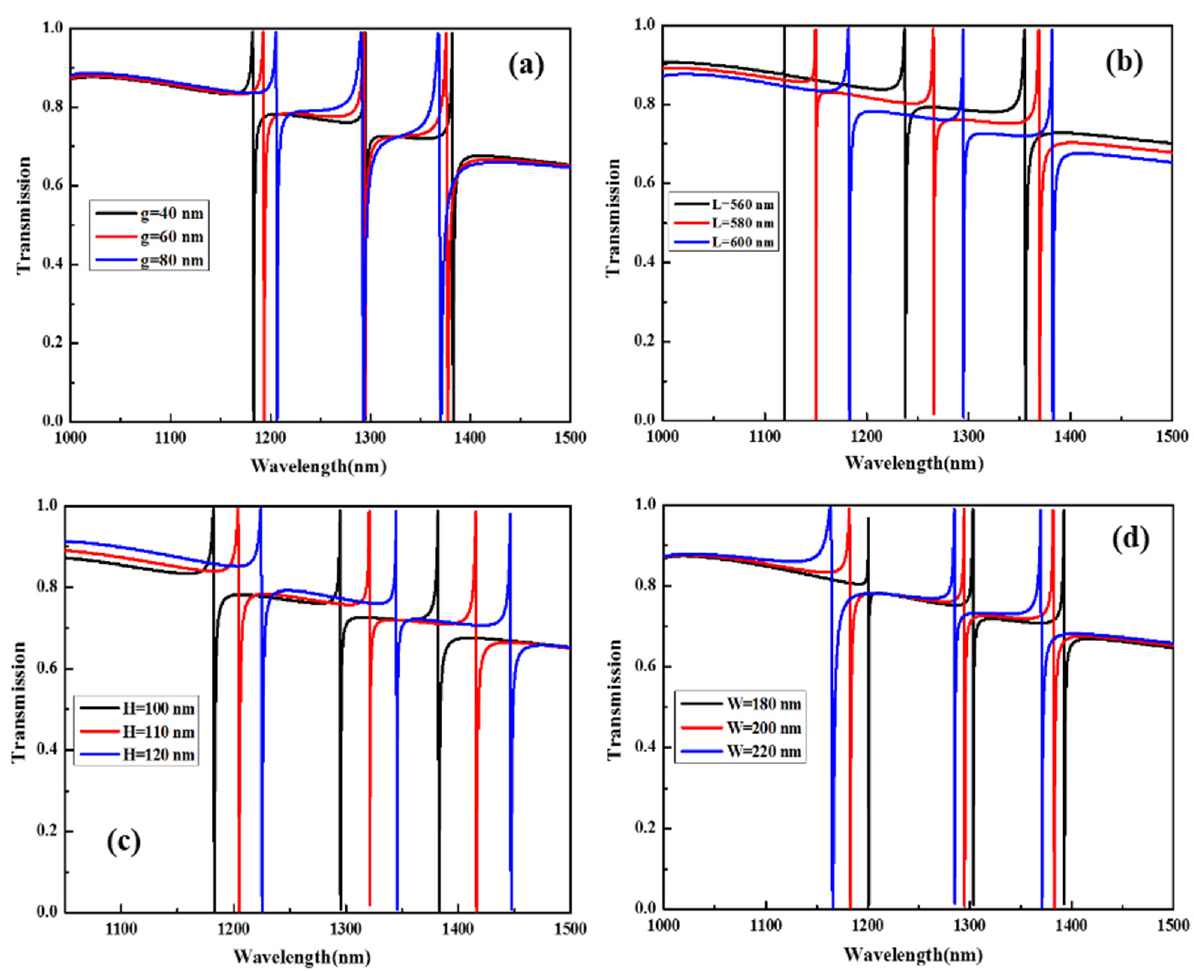
Figure 9. Transmission spectra of multi-Fano resonance of the SHND structure with different ( a ) asymmetry parameter g, ( b ) structure height H, ( c ) outer edge length L, and ( d ) inner cavity width W.